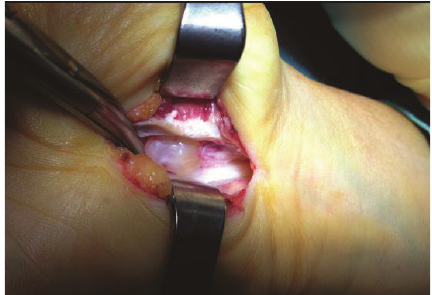
Figure 2: Intraoperative photograph shows the ganglion in the carpal tunnel. The flexor tendons and the median nerve were retracted.